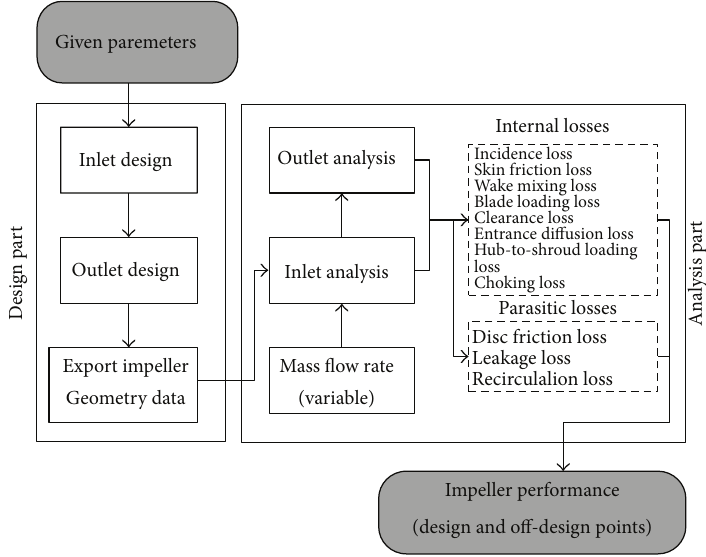
Figure 2: Flow chart of 1D